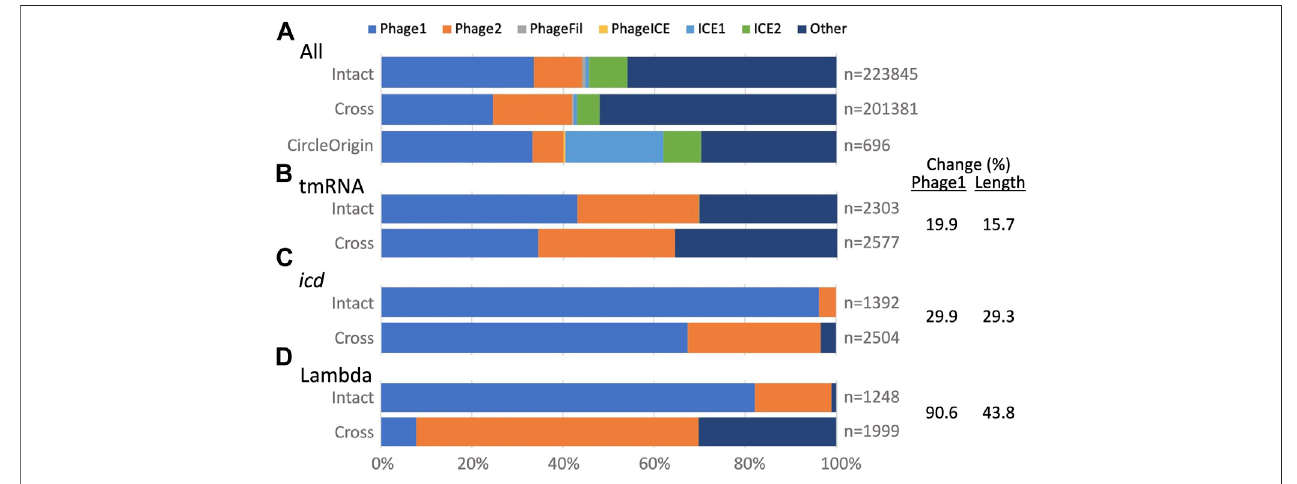
FIGURE 3 | TIGER2 GI type breakdowns for composition categories (Intact, Cross and CircleOrigin). (A) All GIs, or (B – D) GIs at three Escherichia loci. Percent change is given for Intact vs. Cross GIs; change for Phage1 counts correlates with change in GI length across the three